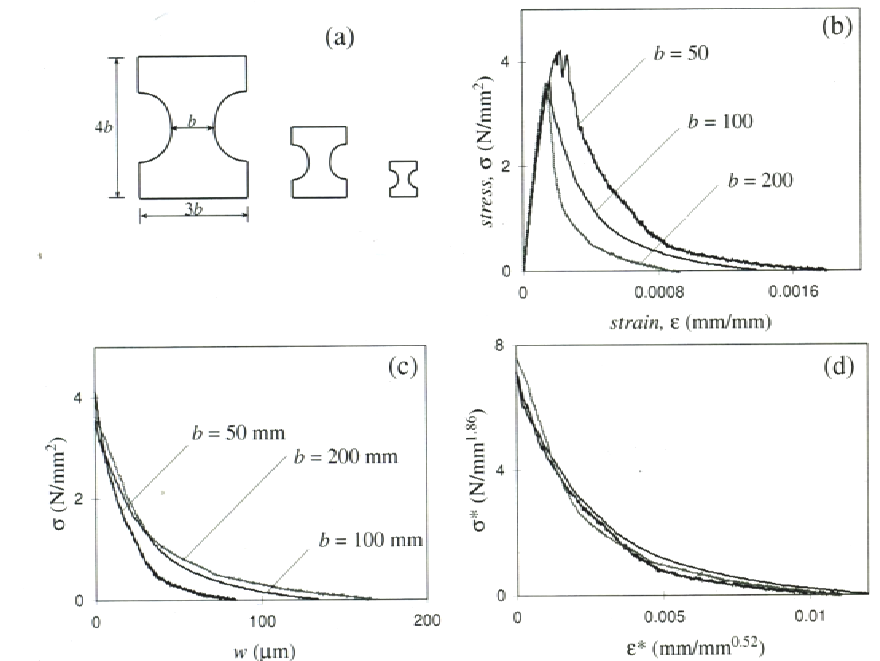
Figure 4: Tensile test on dog-bone shaped specimens (a) by Carpinteri and Ferro [28]; stress-strain diagrams (b), cohesive law diagrams (c), fractal cohesive law diagrams